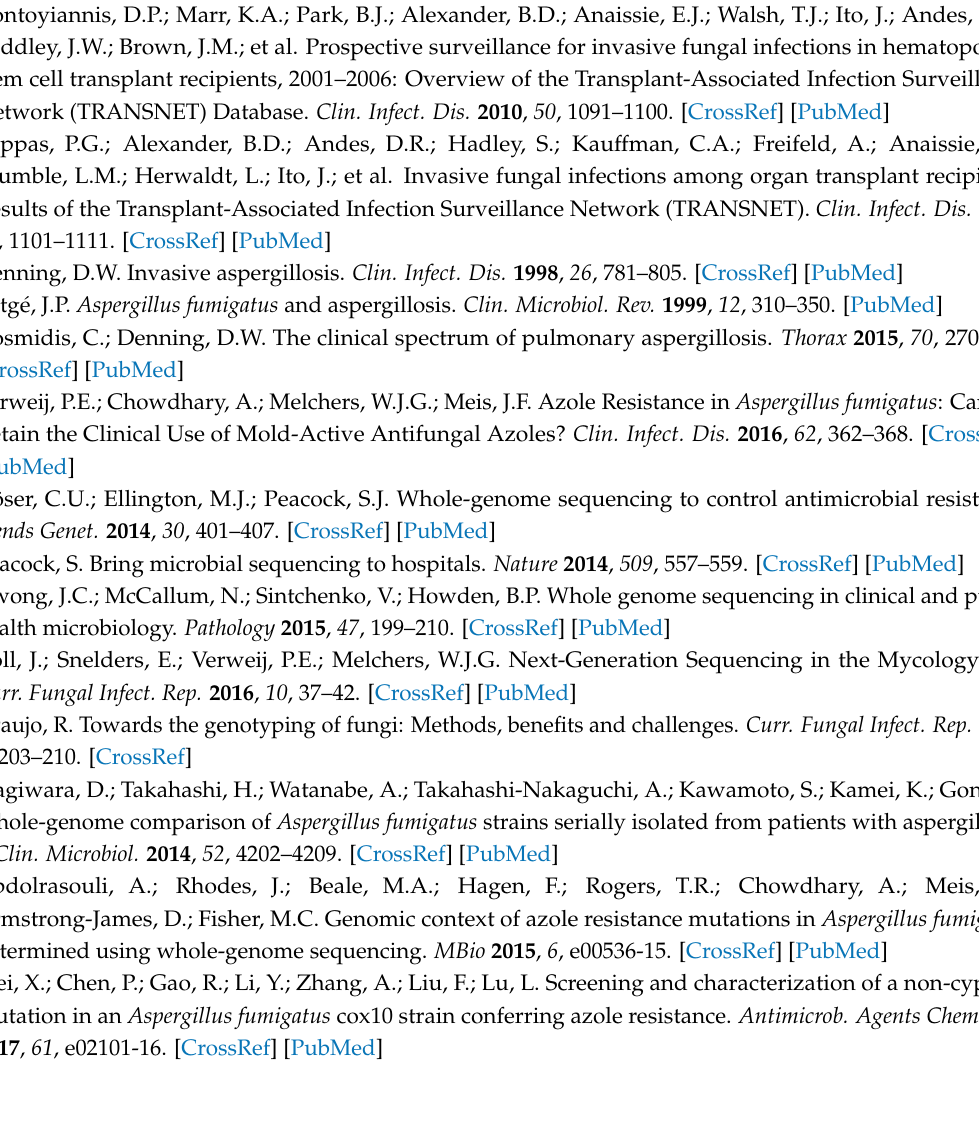
and using A1163 as reference genome. Table S5: MEGA genetic distance estimations: pairwise distance matrix calculating the number of differences and using A1163 as reference genome. Table S6: MEGA genetic distance estimations: mean distances within subclusters calculating the proportion and number of differences and using Af293 as reference genome. Table S7: MEGA genetic distance estimations: mean distances within subclusters calculating the proportion and number of differences and using A1163 as reference genome. Table S8: MEGA genetic distance estimations: matrix of the mean distances between subclusters calculating the proportion and number of differences and using Af293 as reference genome. Table S9: MEGA genetic distance estimations: matrix of the mean distances between subclusters calculating the proportion and number of differences and using A1163 as reference